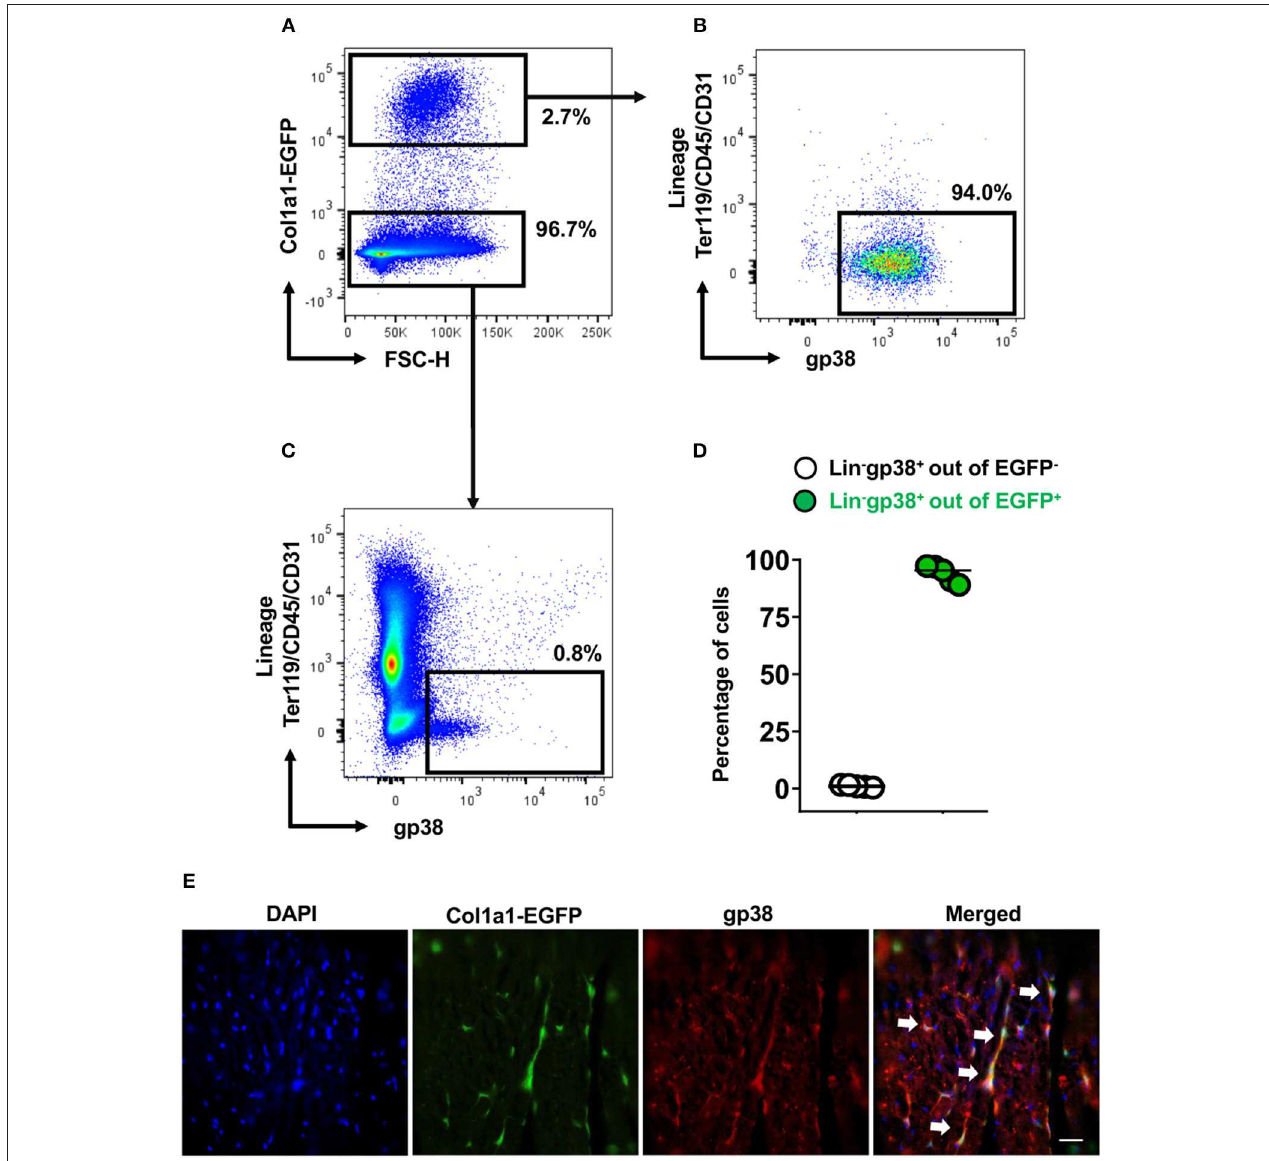
FIGURE 3 | Cardiac Lin − gp38 + cells represent collagen I producing cells. Representative flow cytometry analysis of cells isolated from hearts of Col1a1-EGFP tg mice. Cellular debris below 50k in FSC-A were excluded in SSC-A/FSC-A plots. Live cells were first gated as Col1a1-EGFP + or Col1a1-EGFP − (A) and then analyzed for expression of Lin and gp38. The percentage of Lin − gp38 + cells was quantified from Col1a1-EGFP + cells (B) and Col1 α 1-EGFP − cells (C) . (D) Shows quantification of Lin − gp38 + cell percentages from EGFP − (white circles) and EGFP + (green circles) cells ( n = 5). (E) Shows representative staining of gp38 (red) and EGFP expression (green) indicating the collagen I-producing cells in the cryosections from hearts of Col1a1-EGFP tg mouse. DAPI stains cell nuclei. Bar = 50 µ m.